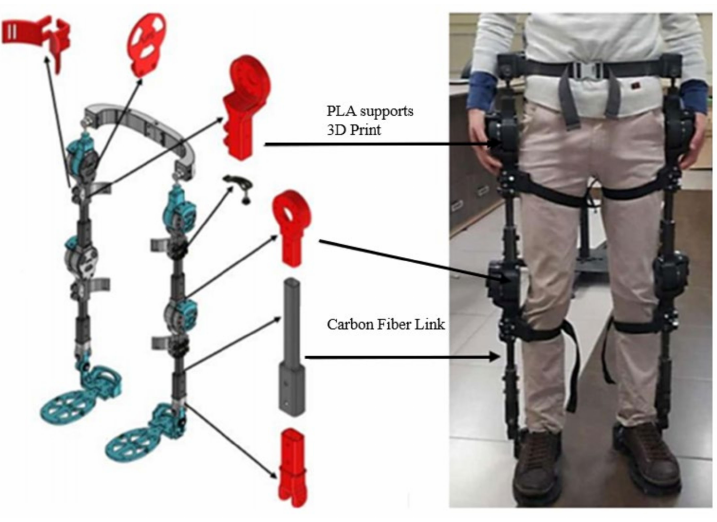
Figure 1. Exoskeleton developed by the